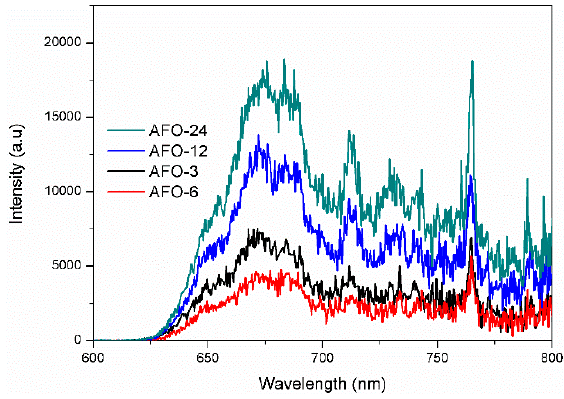
Figure 5. Photoluminescence emission spectra of AgFeO 2 samples with different hydrothermal